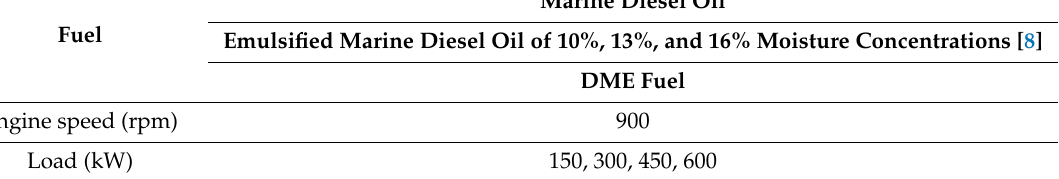
Table 3. Numerical conditions.